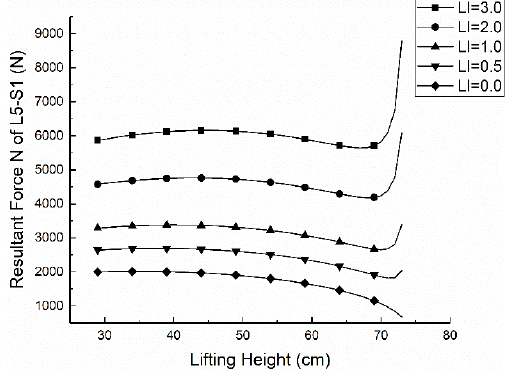
Figure 7. The relationship between N of L5-S1 and h . Int. J. Environ. Res. Public Health 2020 , 17 , x FOR PEER REVIEW